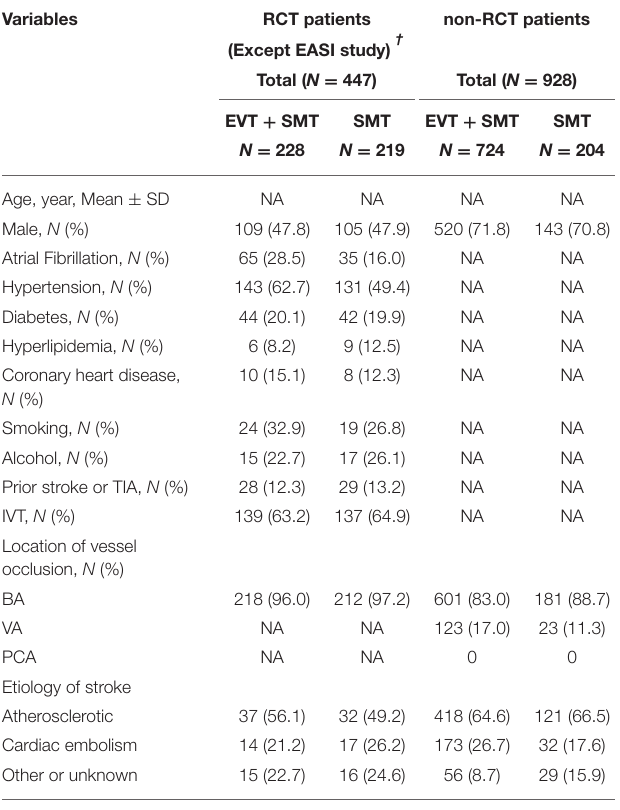
TABLE 2 | Overall clinical characteristics of patients RCT and non-RCT studies. Variables